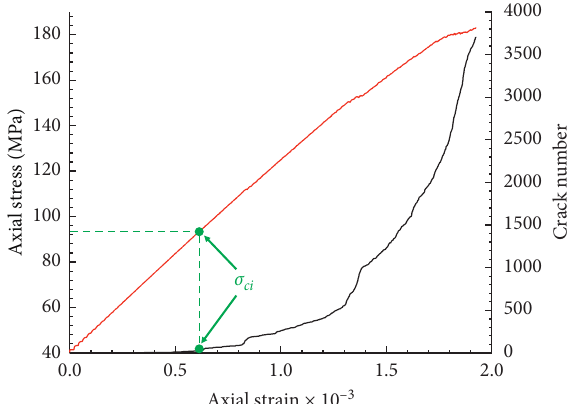
Figure 10: Crack number and axial stress as a function of axial strain.